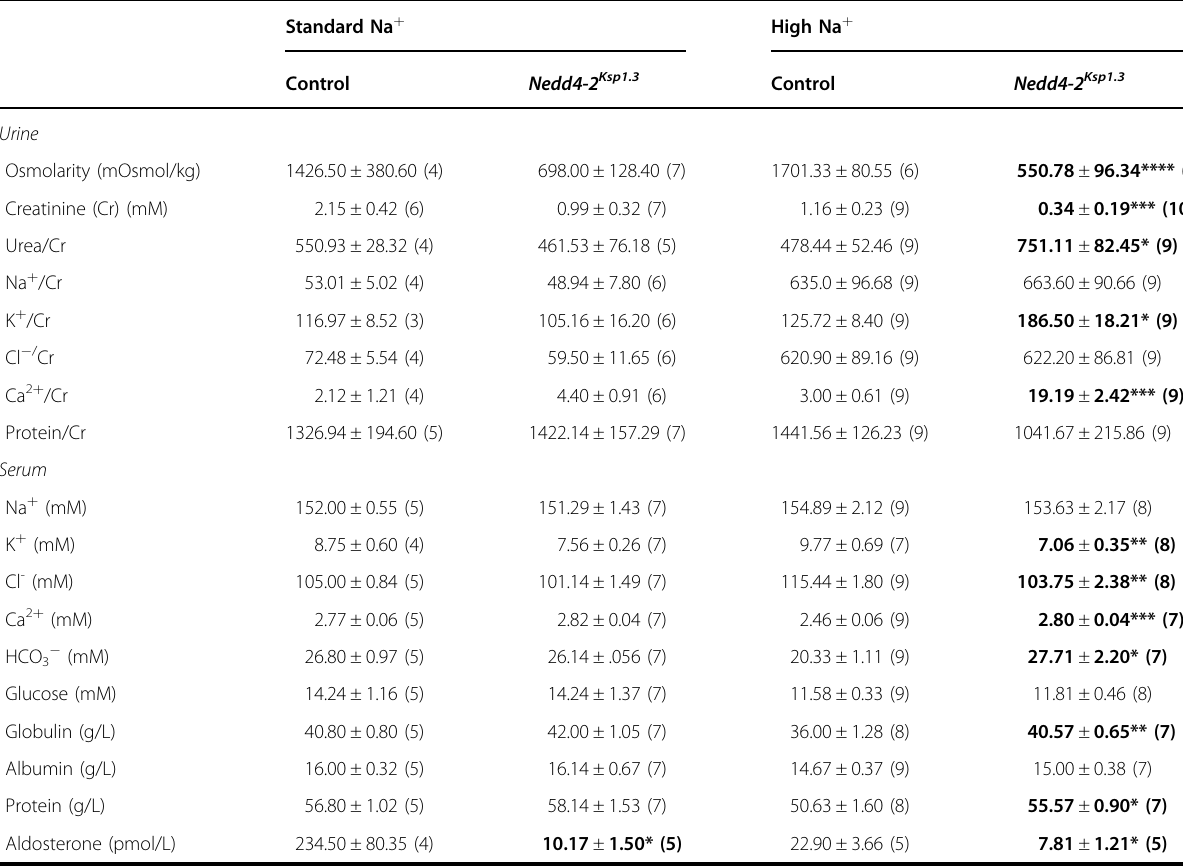
Table 1 Urine and serum analysis of control and Nedd4-2 Ksp1.3 mice on standard and high Na + diets.